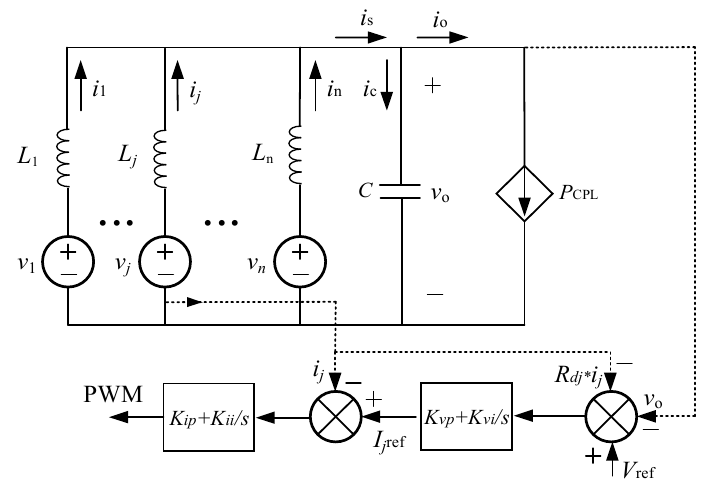
Figure 2. Equivalent circuit diagram of a DC microgrid.